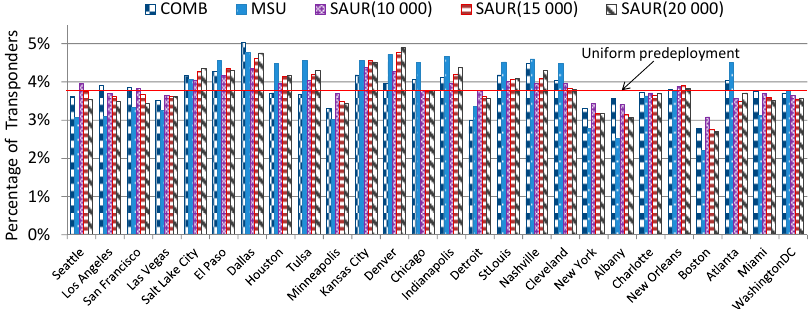
Figure 10. Placement of transponders in nodes of network US26 for tra ffi c profile TP C as a function of